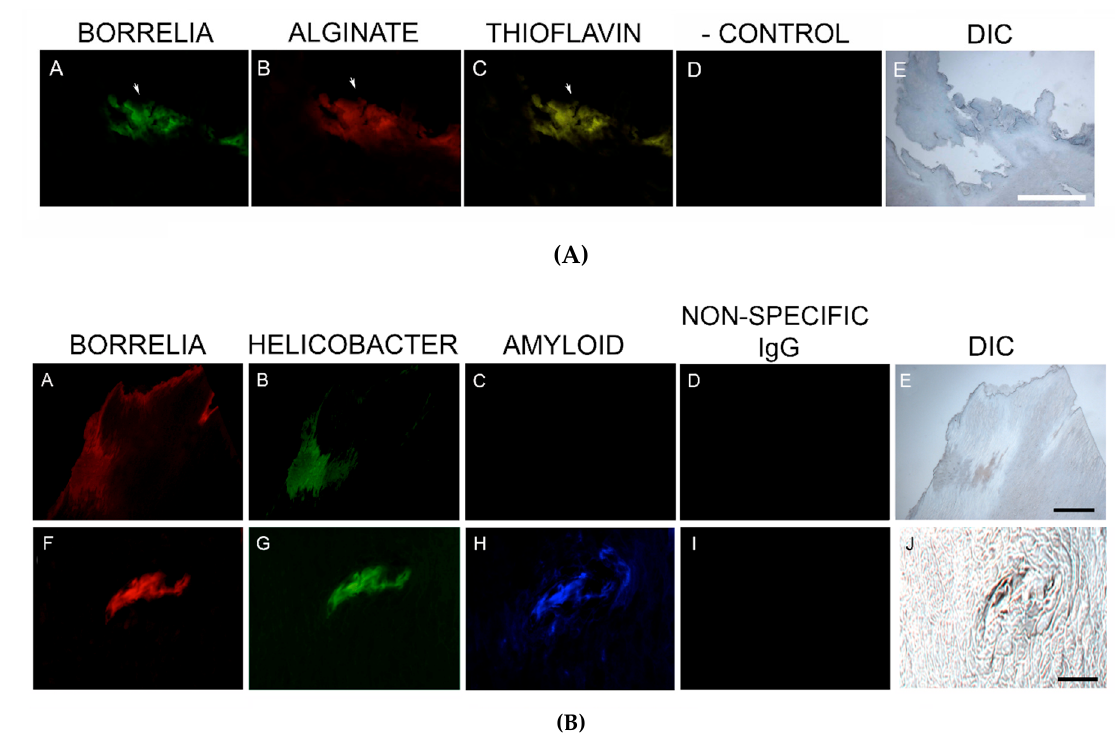
Figure 6. ( A ) Representative images of aggregate biofilm structures in MD skin sections demonstrating positive staining for Borrelia , alginate and Thioflavin S. IHC detection and Thioflavin S staining was performed as described in the Methods section. Panels A and B show positive IHC staining for Borrelia (green) and alginate (red) in aggregate structures. Panel C shows fluorescent staining using Thioflavin S (yellow) on Borrelia and alginate-positive aggregate structures. Panel D shows negative staining with non-specific IgG. Panel E shows the section imaged with DIC. ( B ) Representative IHC images of aggregate biofilm structures demonstrating antibody reactivity with Borrelia , Helicobacter and amyloid in MD skin sections. IHC detection was performed as described in the Methods section. Skin sections were treated with two different fluorescent anti-amyloid antibodies, ABA-1 and ABA-2. Panels A and F show positive fluorescent staining for Borrelia (red), and panels B and G show positive fluorescent staining for Helicobacter (green) in aggregate structures. Panel C shows negative staining using ABA-1, while Panel H shows positive staining using ABA-2 (blue) on Borrelia and Helicobacter -positive aggregate structures. Panels D and I show negative staining with non-specific IgG. Panels E and J show sections imaged with DIC. All images were taken at 200× magnification. Scale bar = 100 µm.